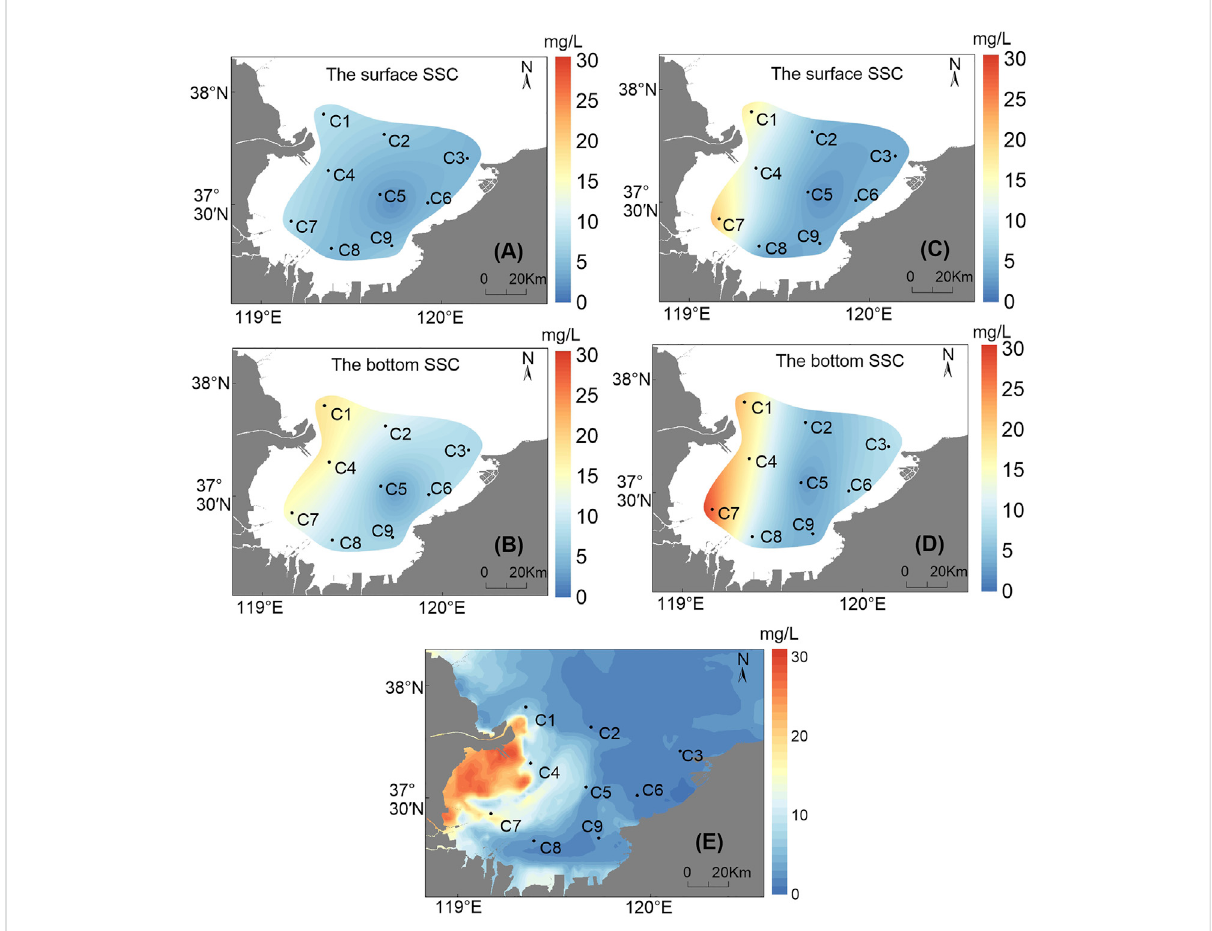
FIGURE 3 Horizontal distribution of the surface SSC (A) and the bottom SSC (B) during the spring tide (May 24 – 25, 2020); horizontal distribution of the surfaceSSC (C) andthebottomSSC (D) duringthemoderatetide(April27 – 28,2020). (E)